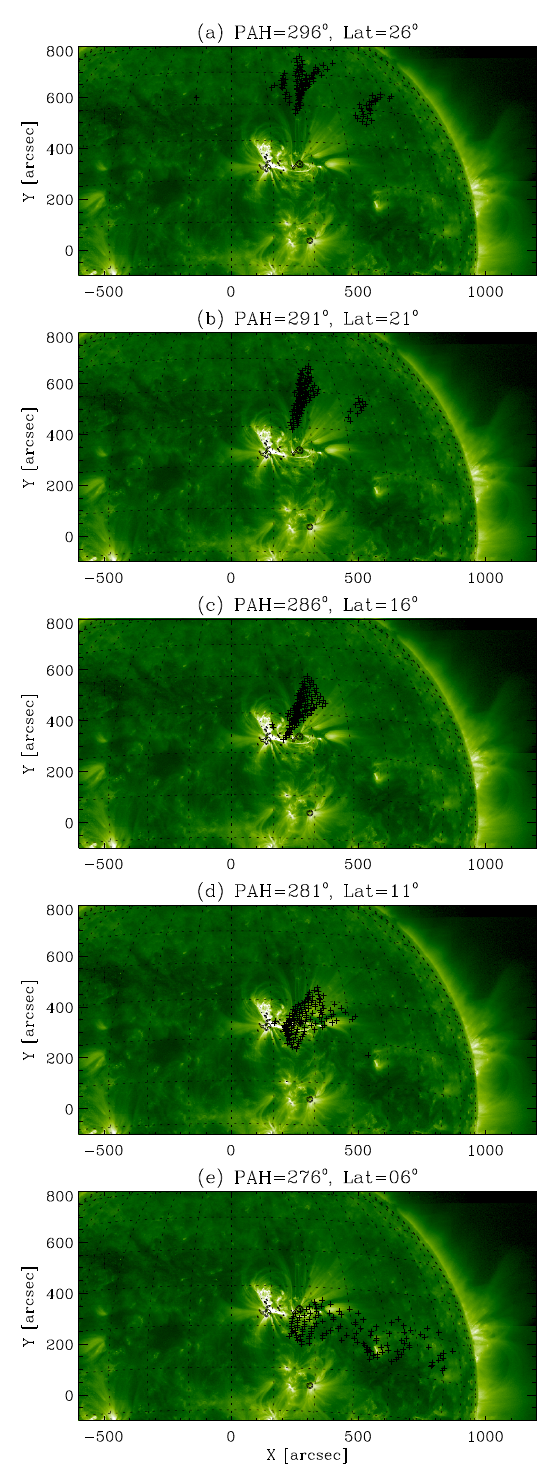
Fig. 4. Two-dimensional spatial relation between layer best (IR emission sources inferred by Liu and Lin’s method; marked by black plus signs) and the EUV bright features on disk. The magnetic field contours denote the sunspots positions on the photosphere.